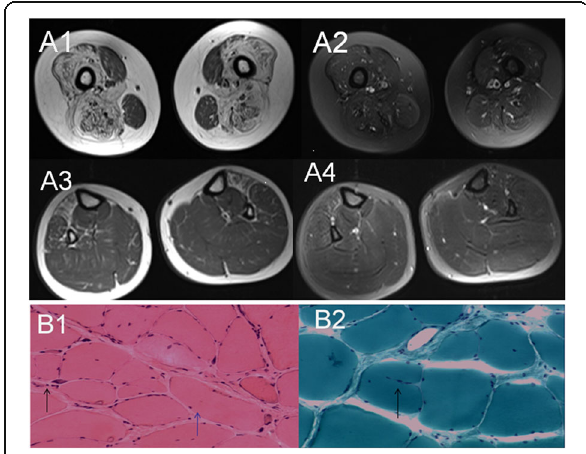
Fig. 4 A1-4: The MRI of proband. A1-2 MRI revealed the bilateral thigh muscle disappear, the normal form was filled with a wide range of adipose tissue; A3-4 MRI showed the anteromedial calf group of muscles was infiltrated mild fatty. B1-2: Physical performance of proband; B1 (HE, ×100): the pathological changes in muscles showed that the sizes of muscle fibers were different, fiber atrophy ( black arrow ) and hypertrophy ( blue arrow ) alternately existed, compensatory hypertrophy of partial muscle fibers existed, fat and connective tissue proliferations were apparent. B2 (MGT, ×200): split muscle fibers can be seen in the hypertrophy muscle fibers ( black arrow )